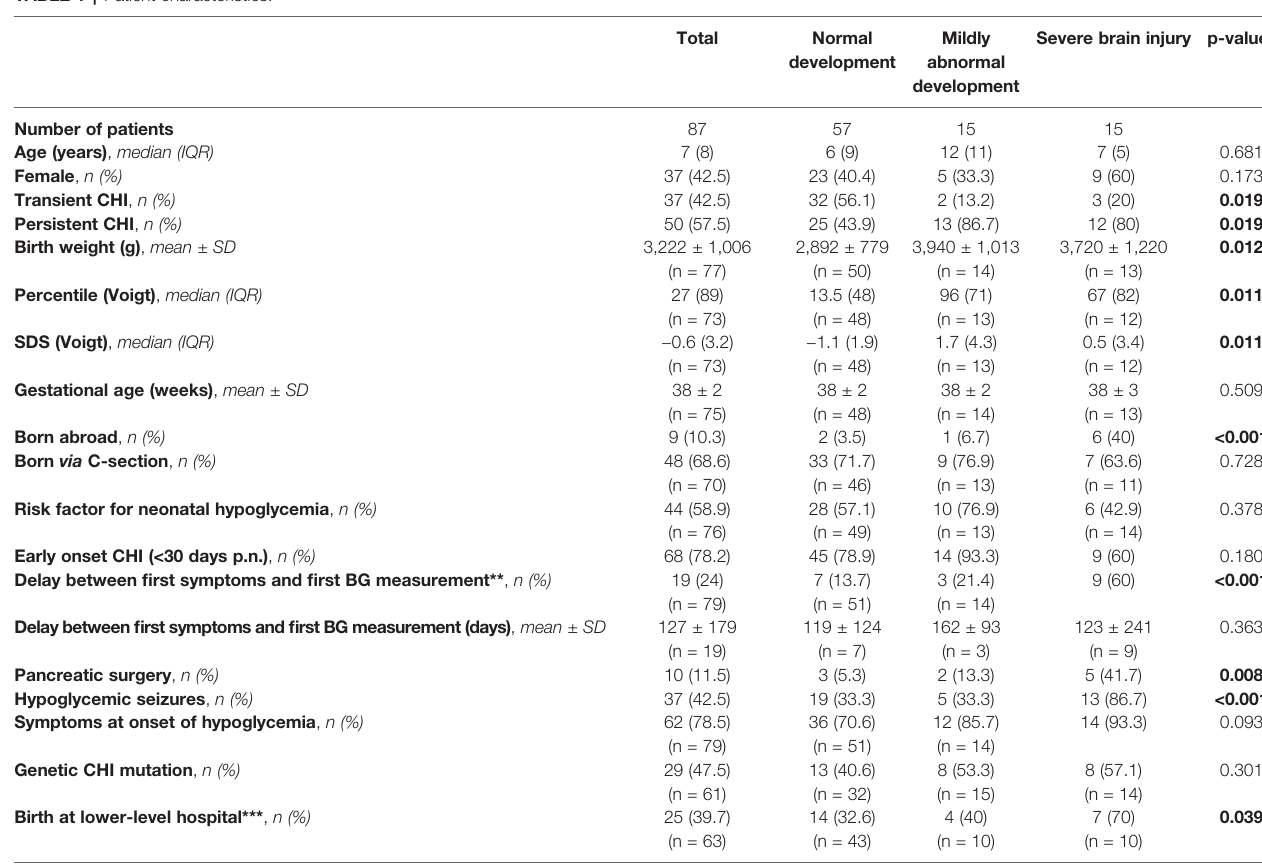
TABLE 1 | Patient